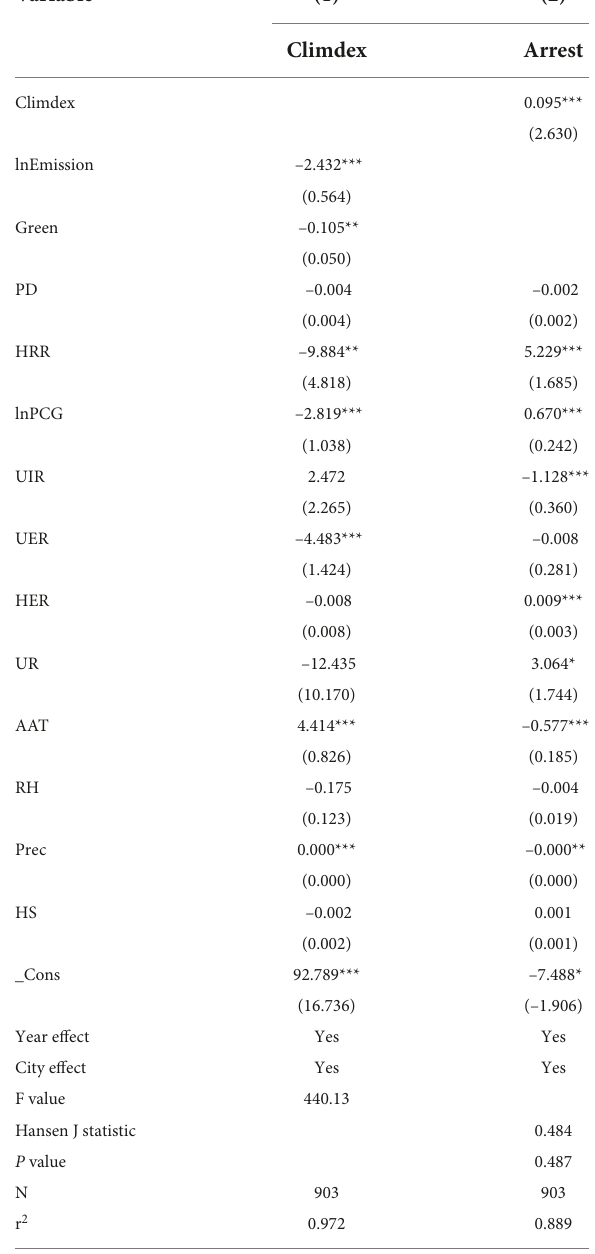
TABLE 3 Endogeneity test results of regression